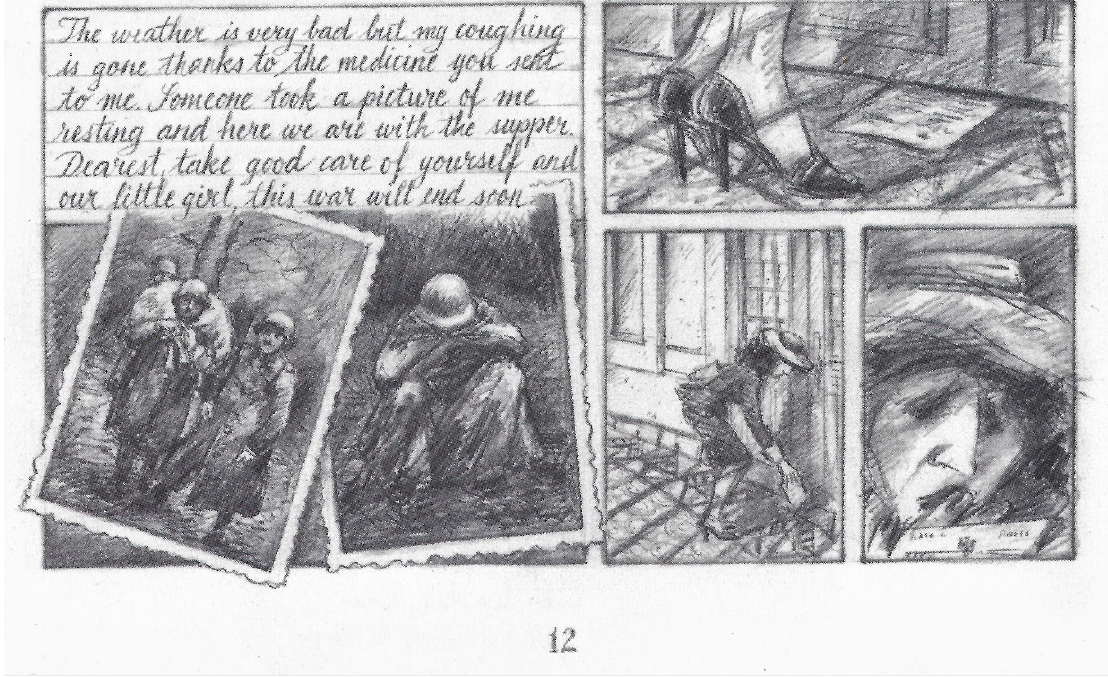
Figure 4. We Are On Our Own (Katin 2006). Reproduced by permission of Miriam Katin.